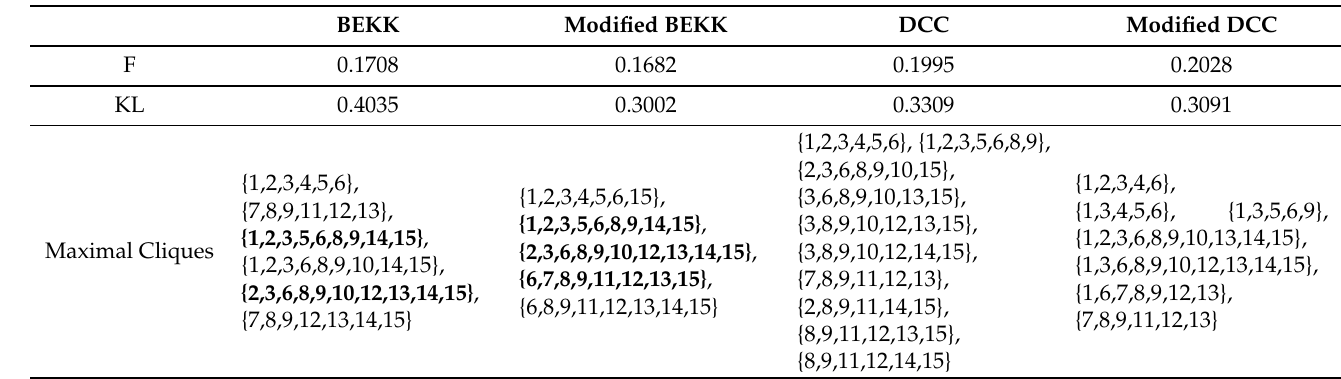
Table 7. Values of the Frobenius and the Kullback–Leibler loss functions and the maximal cliques: case N = 15 and δ = 0.5. In bold the cliques of the simulated graphs that coincide to the ones of the original graph G ( δ ) .